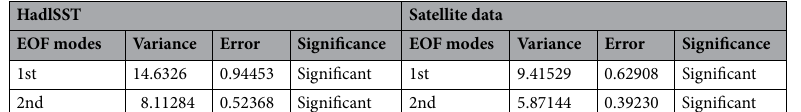
Table 1. Significance of EOF methods using North Criteria.